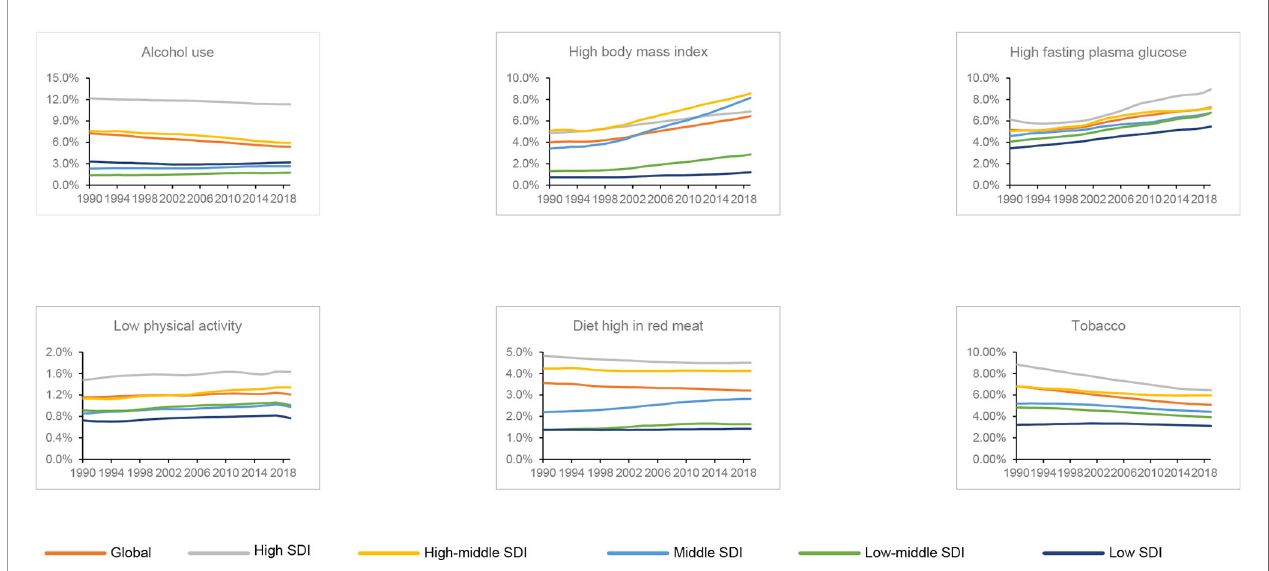
FIGURE 5 | Contributions of different risk factors to breast cancer deaths globally and in fi ve sociodemographic index (SDI) quintiles from 1990 to